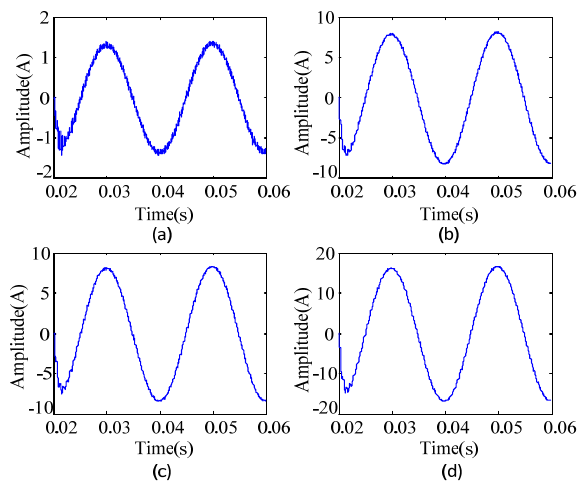
Figure 14. TZSCs for SPG fault (Case 3). ( a ) Lian L 1 ; ( b ) Lian L 2 ; ( c ) Lian L 3 ; ( d ) Lian L 4 .